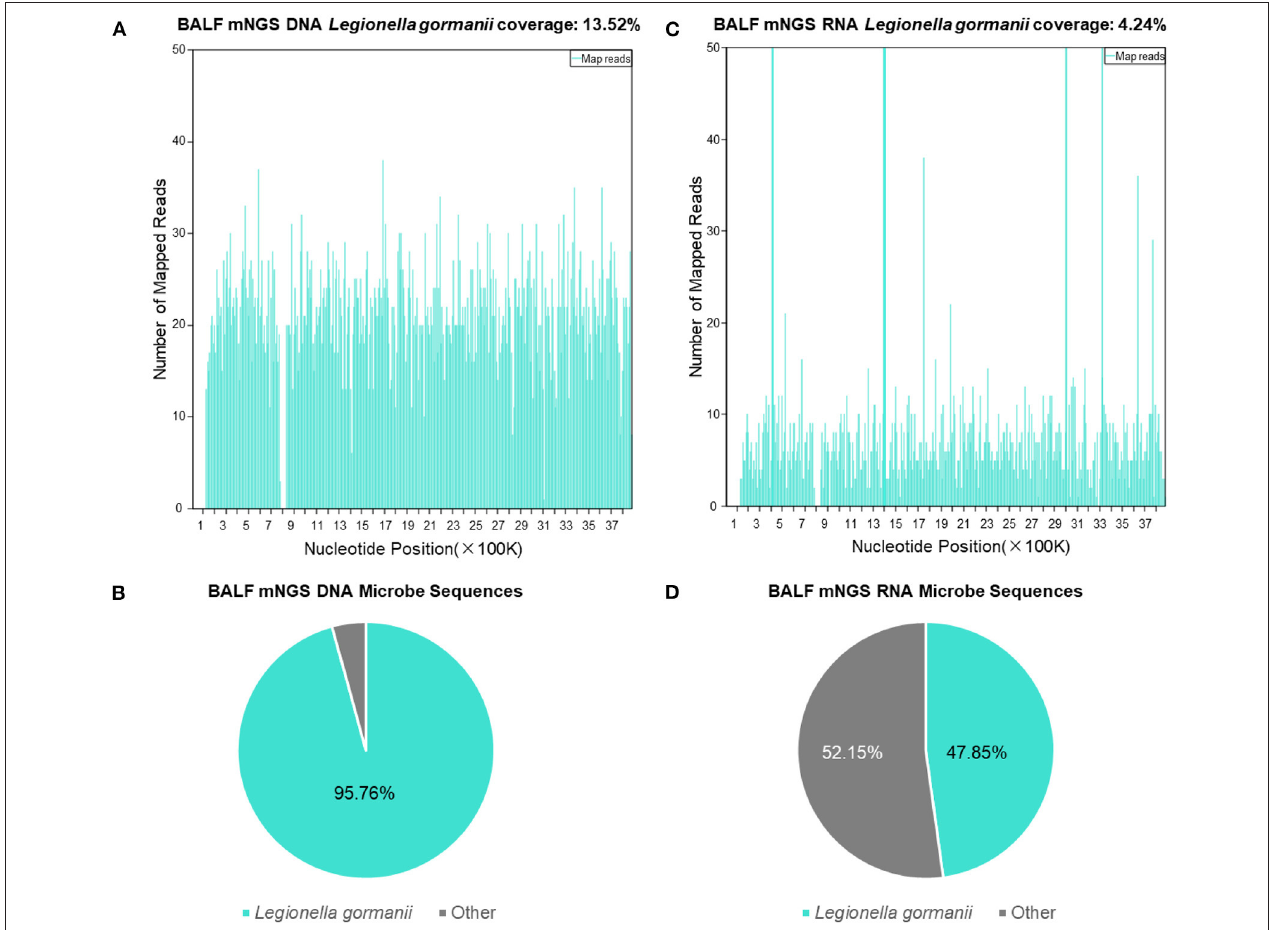
FIGURE 3 | The bronchoalveolar lavage fluid mNGS results of the patient. (A) The DNA mNGS results showed that the coverage of Legionella gormanii was 13.52%. (B) 95.76% of the microbe DNA sequences were Legionella gormanii . (C) The RNA mNGS results showed that the coverage of Legionella gormanii was 4.24%. (D) 47.85% of the microbe RNA sequences were Legionella gormanii